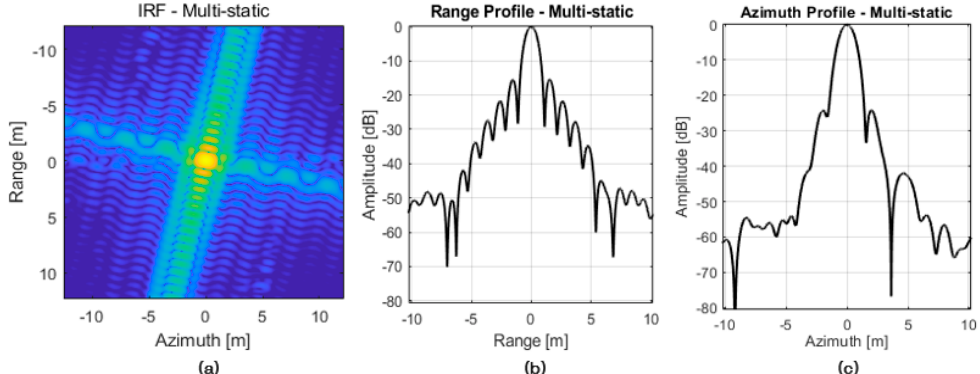
Figure 21. Multistatic SAR imaging simulation results reflecting the phase-correction algorithm in the case of a baseline of 6 km and a determined orbit. IRF ( a ), range profile ( b ), and azimuth profile ( c ).